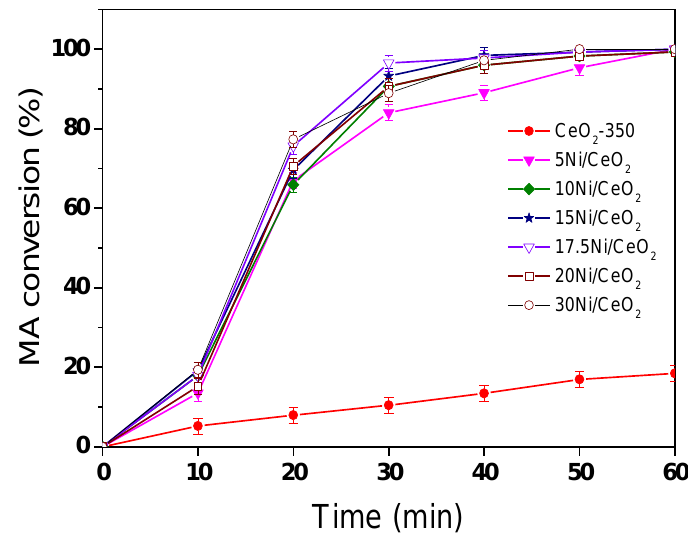
Figure 11. The conversion of MA on reduced the xNi/CeO 2 catalysts. In order to further investigate the C=C hydrogenation performance of xNi/CeO 2 catalysts, the turnover frequency values for MA to SA (TOF MA → SA ) over the active Ni were calculated and correlated with the oxygen vacancies, Ni species, and Ni loading content. As shown in Figure 12, the TOF MA → SA of the xNi/CeO 2 catalysts decreased as the Ni content increased, which was consistent with the change trend of oxygen vacancies on the surface, indicating that the oxygen vacancies of the catalyst also played an important role in the C=C hydrogenation of MA. According to H 2 -TPR and H 2 -TPD results, oxygen vacancies not only improved the dissociation and adsorption capacity of H 2 on the catalyst but promoted the diffusion of active H on the catalyst surface, providing more active H species for the hydrogenation reaction [37]. Moreover, according to theoretical calculations, oxygen vacancies with rich electron structure can provide electrons to the active metal and enhance the electron-giving ability of the active metal, thus improving the C=C hydrogenation performance of the metal [40]. For the xNi/CeO 2 catalytic system, it can be speculated that the synergistic effect between active metal Ni and oxygen vacancies (Ovac) could have improved the C=C hydrogenation performance of Ni.